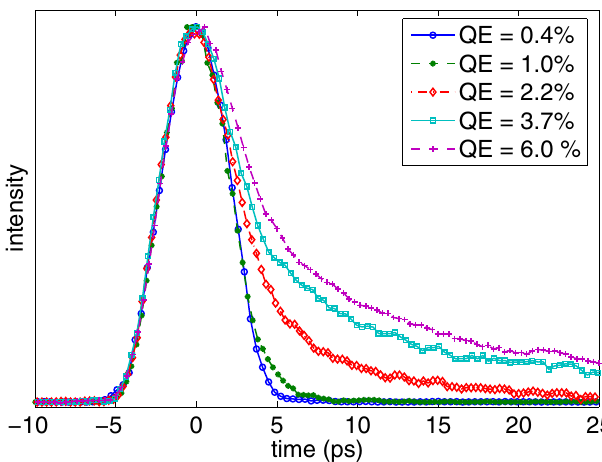
FIG. 9. (Color) Temporal response obtained from GaAsP ex- cited by 1 ps rms 520 nm laser pulse for different QE values.